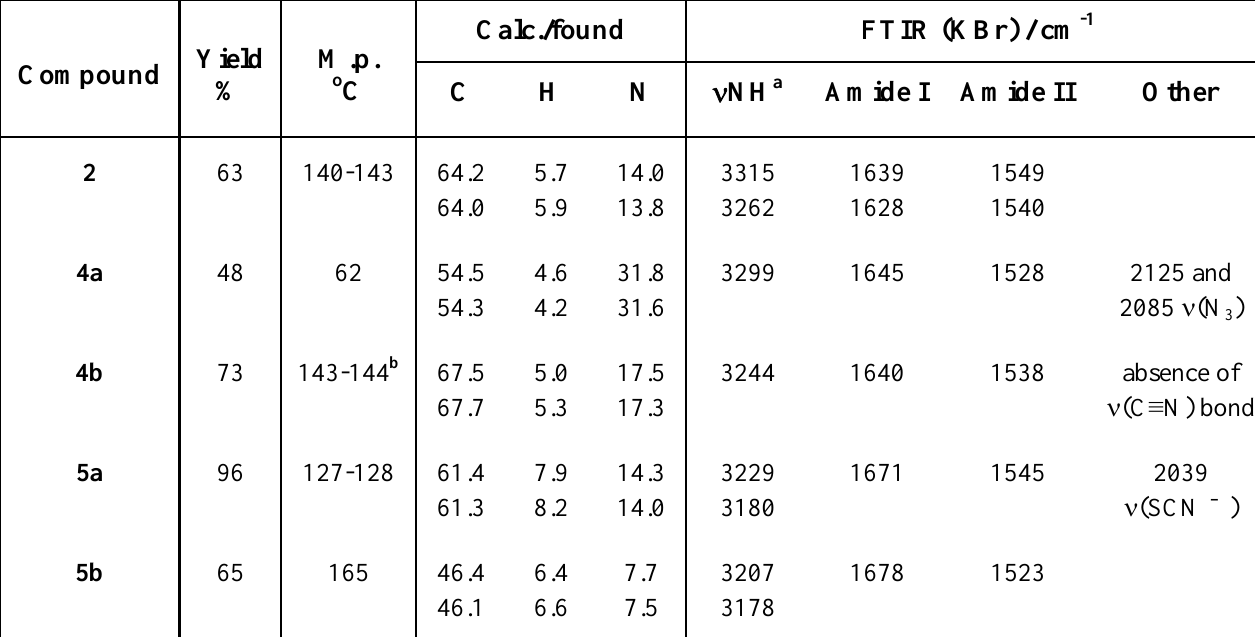
Table 1. Physicochemical data of compounds 2 - 5b